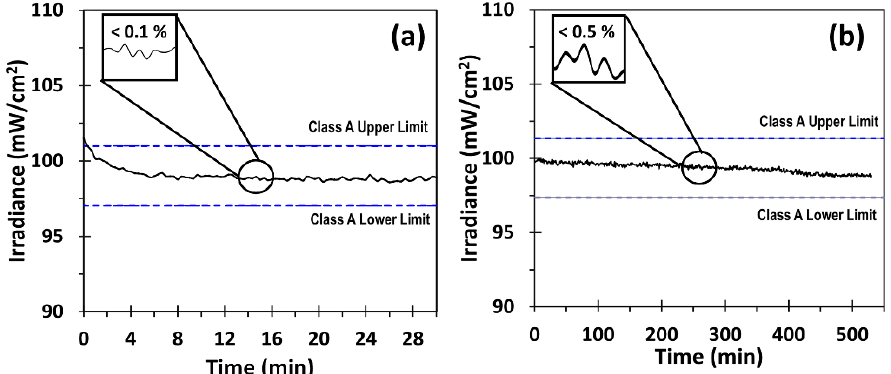
Figure 9. ( a ) The changes in light intensity during the warming-up period of 30 min utilizing a 250-millisecond data acquisition time. ( b ) The irradiance from the LED LASS system as a function of time for 550 min of continuous operation; the measurements were recorded after stabilizing the system for 5 min. The blue dotted lines represent the Class A upper and lower limits of (±2%).